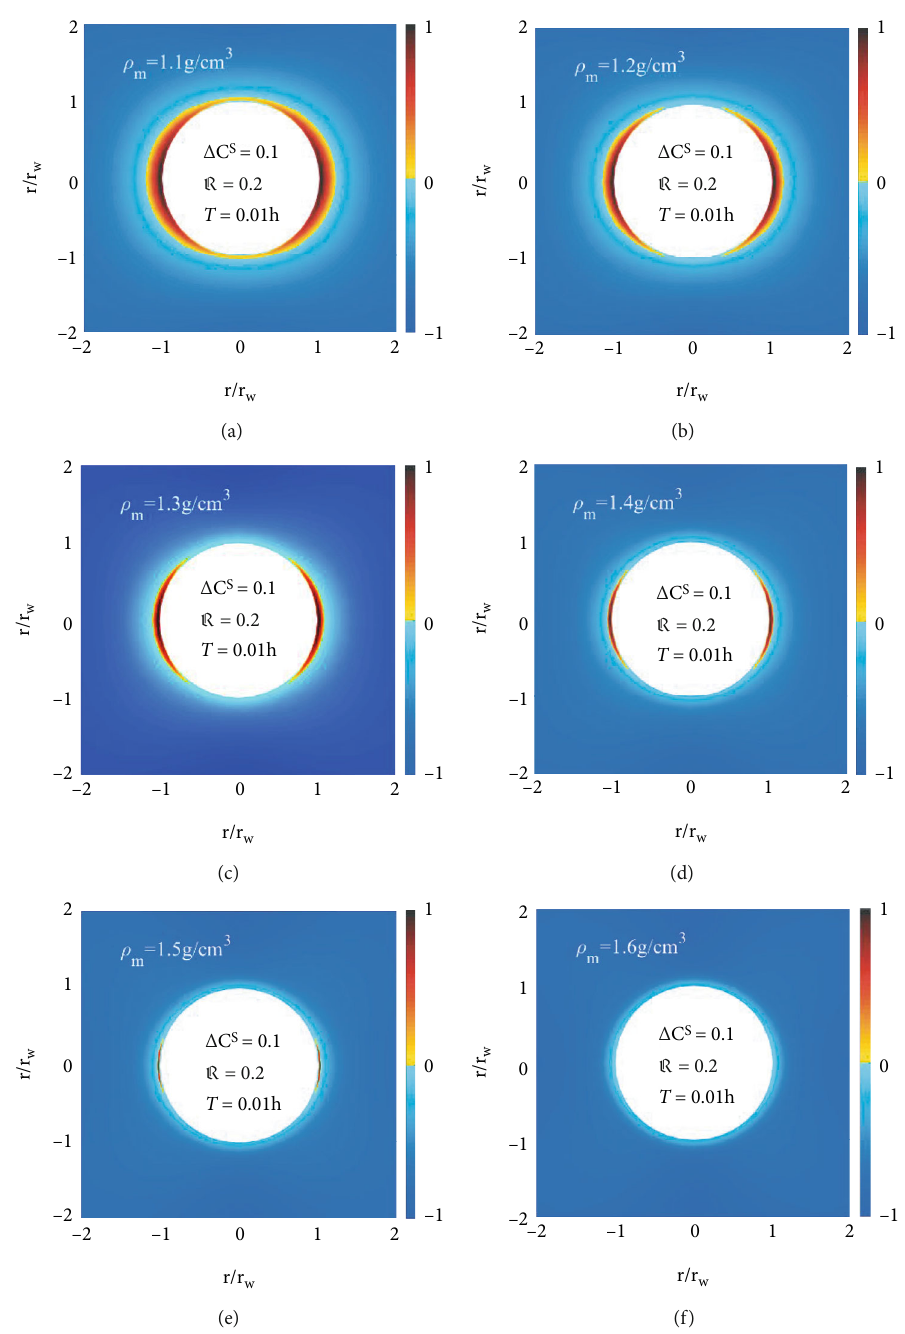
Figure 17: Damage zone around the wellbore for a mud density of (a) 1.1g/cm 3 , (b) 1.2g/cm 3 , (c) 1.3g/cm 3 , (d) 1.4 g/cm 3 , (e) 1.5g/cm 3 , and (f) 1.6g/cm 3